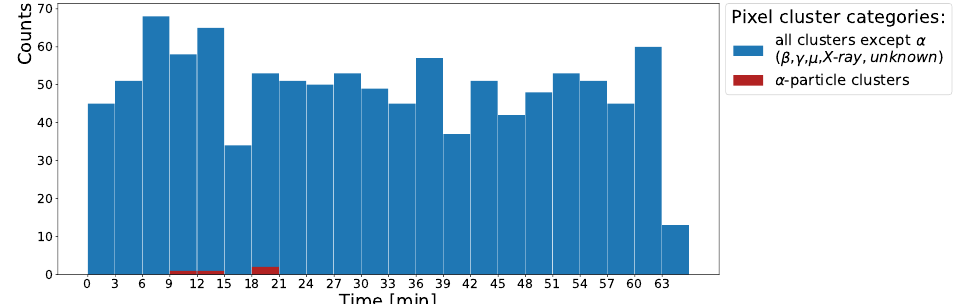
Figure 8. Histogram of KCl radioactivity measured for 1 h using the hybrid pixel detector. The last bin on the right shows the background rate without KCl. Four α -particles are detected in the first half of the measurement as part of indoor radioactivity caused by radon.